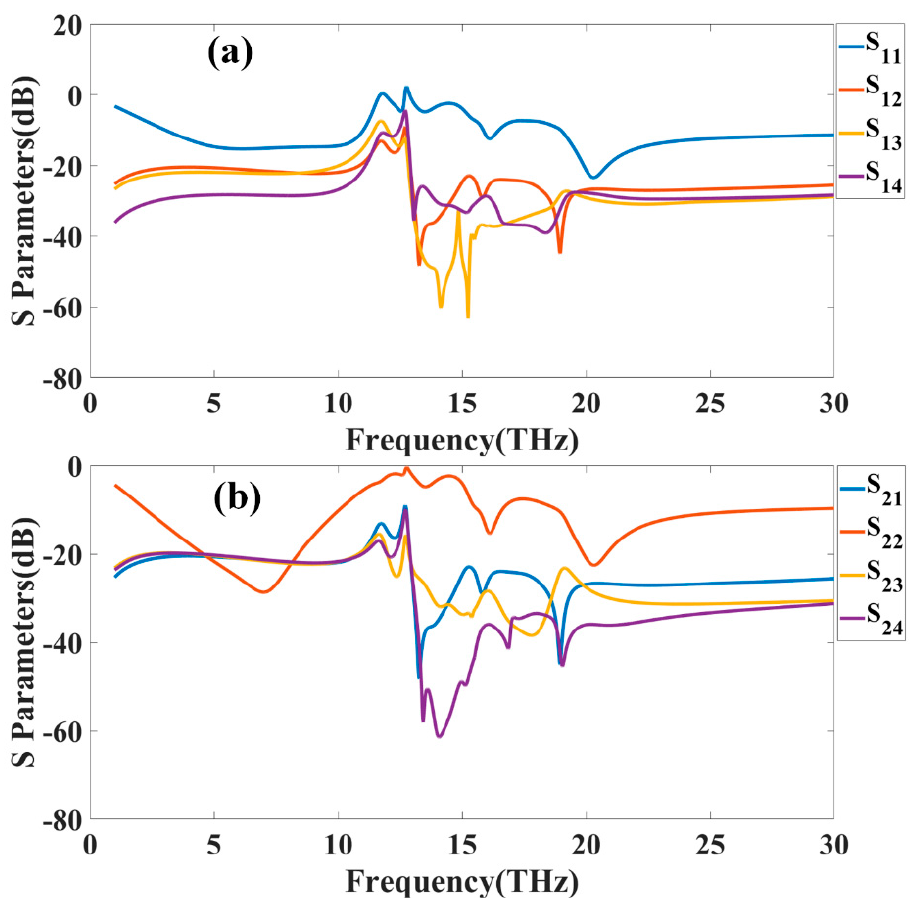
Figure 2. Calculated S-parameters for the Type-1 antenna (2 × 2 structure) by considering ( a ) port-1 and ( b ) port-2 as exciting